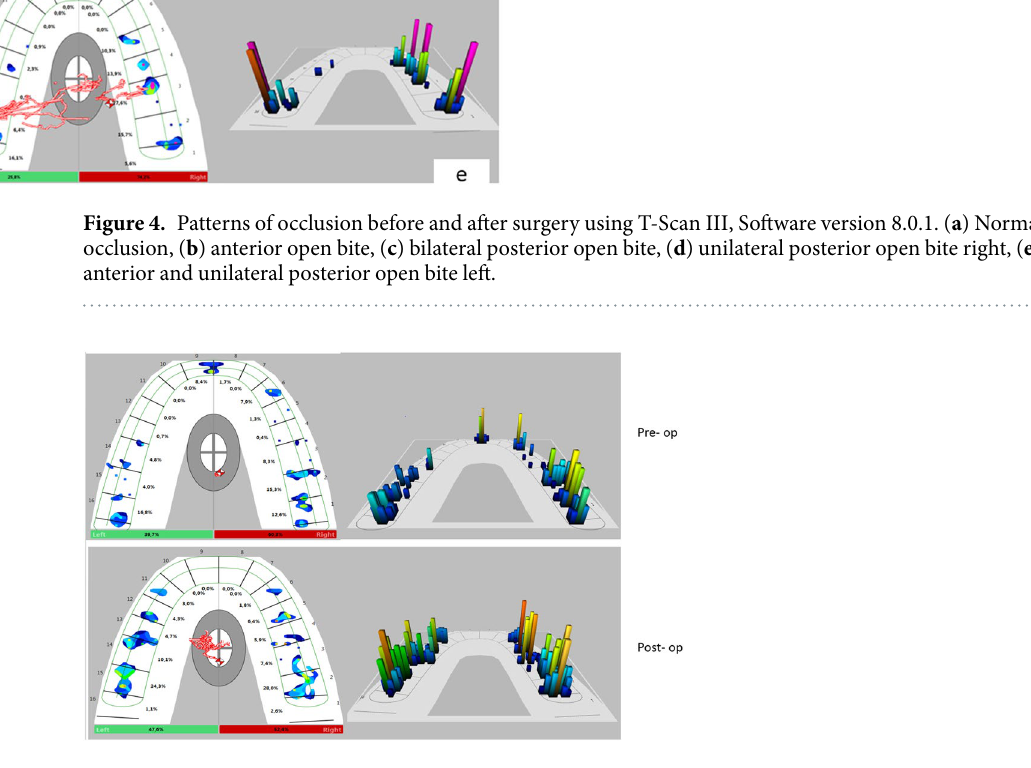
Figure 5. Occlusal force distribution before and 1 year after surgery using T-Scan III, Software version